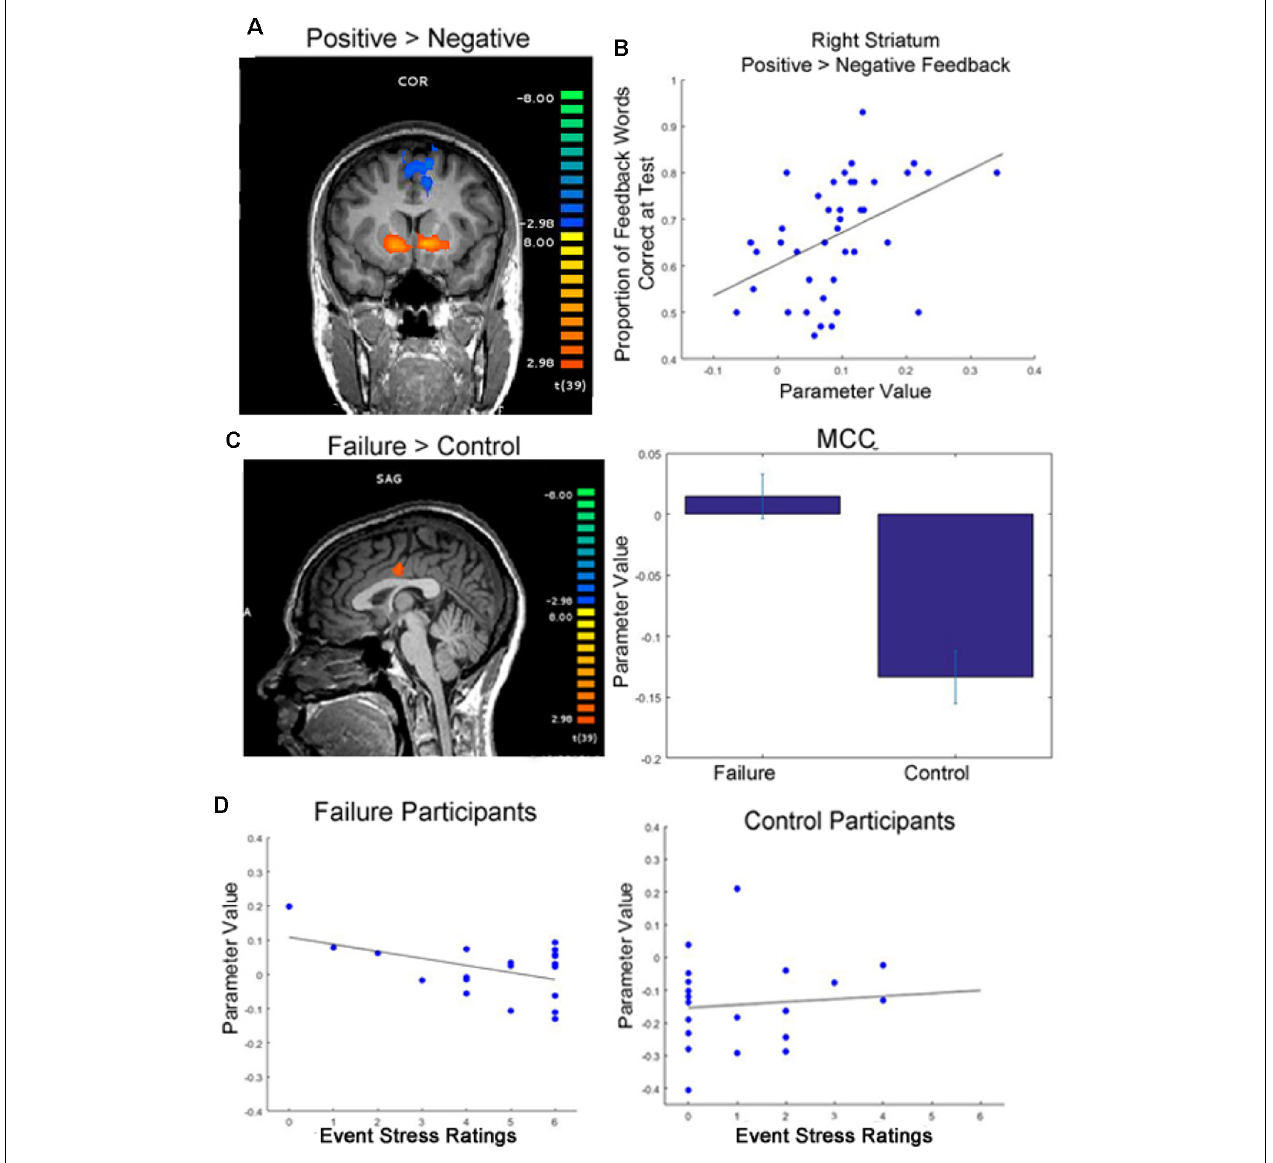
FIGURE 3 | Functional magnetic resonance imaging (fMRI) results. (A) Participants showed greater activation in the striatum when viewing positive feedback than negative feedback during round 2 of the learning phase, when feedback was meaningful for performance ( p < 0.05, cluster corrected; initial cluster forming threshold p < 0.001). (B) Greater differential activation in the right dorsal striatum when viewing feedback was significantly correlated with later memory for feedback words. (C) Participants who were randomly assigned to write about past failures showed greater activation in the mid cingulate cortex (MCC) while viewing target words throughout the learning phase than participants who wrote about a trivial topic ( p < 0.05, cluster corrected, initial cluster forming threshold p < 0.005; peak activation coordinates in Talaraich space: − 4, − 11, 30). Whereas control subjects showed typical decreases in activation in the MCC during the task, failure subjects’ activation was near baseline averaged around 0 (right). (D) Individual differences in self-reported event stress ratings significantly predicted MCC deactivation for failure participants (left). We did not see this same relationship for control subjects